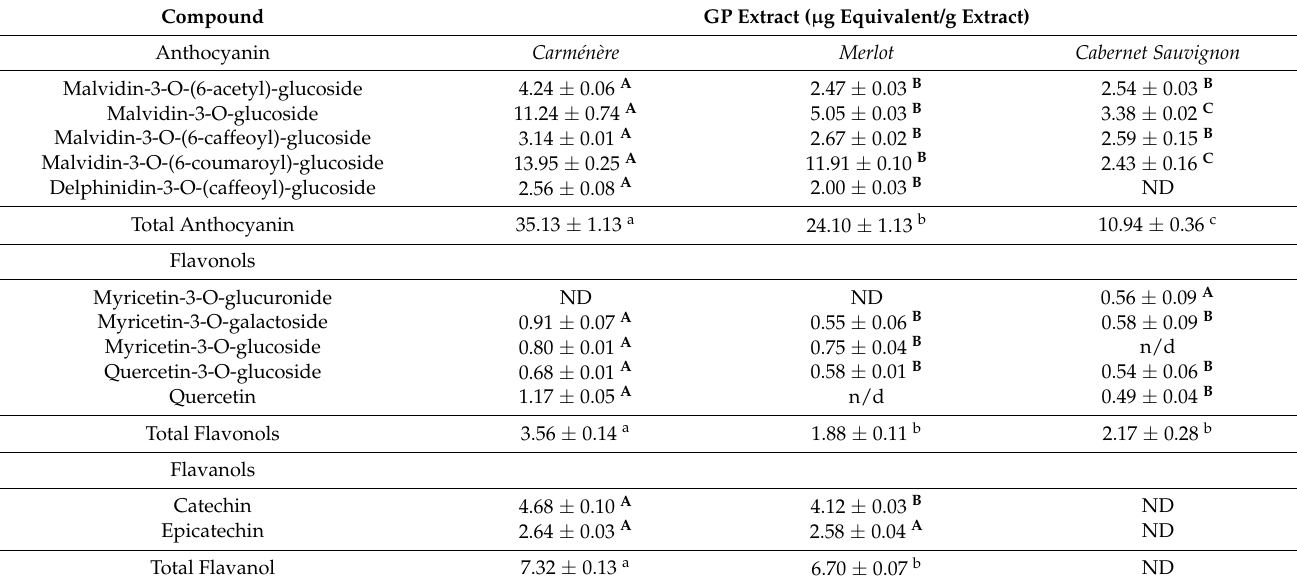
Table 2. The concentration of polyphenols in GP extracts. Means with a common capital letter are not significantly different ( p > 0.05). Capital letters indicate significant differences between a compound in different extracts. Lowercase letters indicate significant differences between total values in different extracts. ND: Not detected